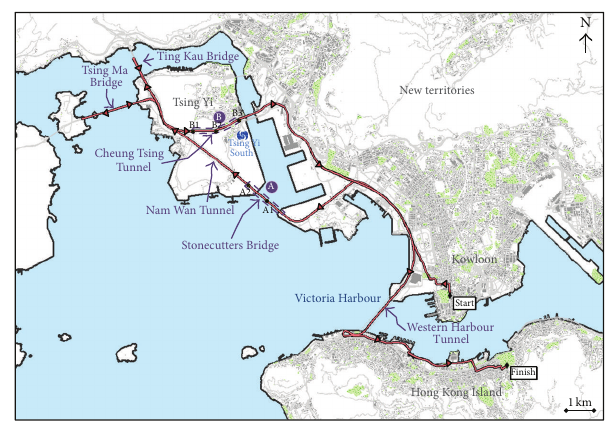
Figure 1: The 2012 Hong Kong Standard Chartered Marathon Route with study sites and sampling locations